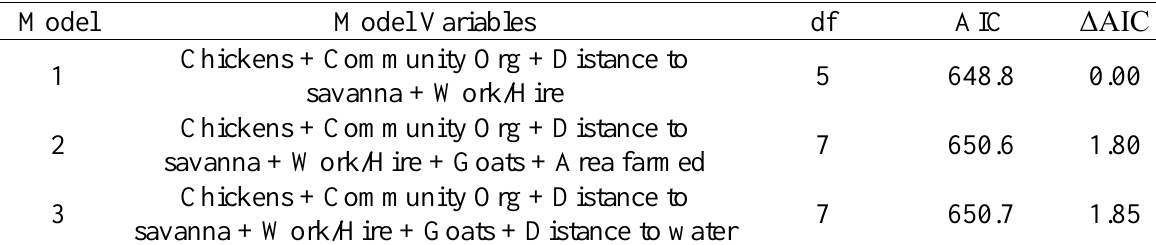
Table A2.2 Akaike information Criteria (AIC), change in AIC (ΔAIC) and degrees of freedom (df) from the top competing regression models of household adaptation attempts as a function of individual indicators of household capital.